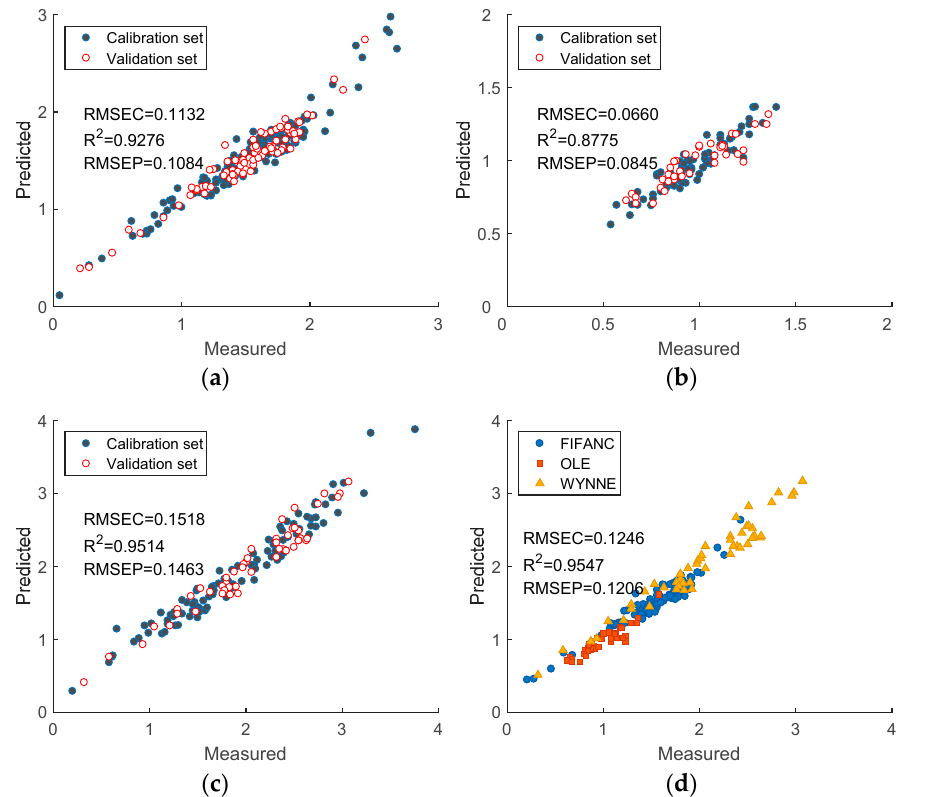
Figure 4. The prediction results of the models based on the DE segmentation algorithms for the calibration sets and the validation sets: ( a ) Florida Fancy; ( b ) OLé; ( c ) Wynne; ( d ) combined sample with all three cultivars.